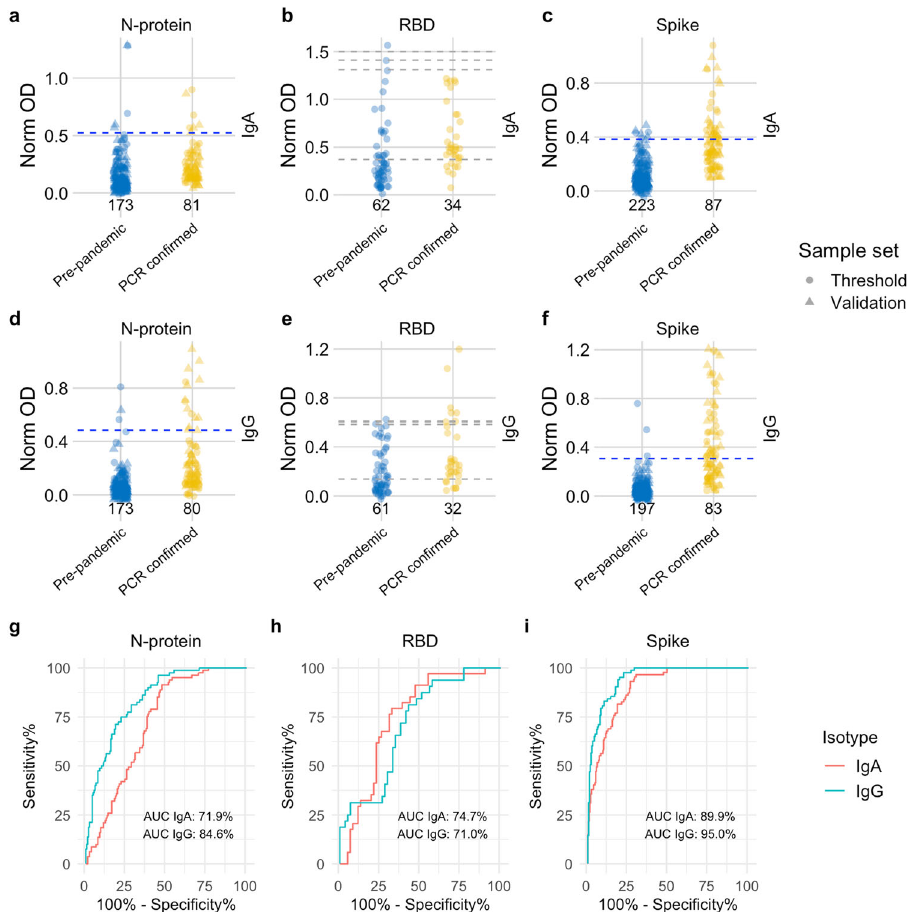
Fig. 2 Distribution of semi-quantitative titres for each assay and corresponding ROC curves. a – c Dotplots show the scatter of values for SARS-CoV-2 speci fi c IgA responses against N-protein ( N = 254), RBD ( N = 96) and spike ( N = 310), speci fi c IgG responses against N-protein ( N = 253), RBD ( N = 93) and spike ( N = 280) are shown in ( d – f ). Data are presented for known negative and known positive samples, the number of samples tested in each group is also shown under the corresponding data points. For N-protein and spike, proposed thresholds (97th – 99th percentile and Youden ’ s index) are shown as dashed lines, with the fi nal selected threshold in blue; thresholds were derived in the threshold setting phase (threshold samples shown as circles, validation samples shown as triangles). RBD was not taken forward to full evaluation, so performance in the threshold set and corresponding proposed thresholds are shown as dashed grey lines. g , i ROC curves for N-protein and spike represent assay performance determined on all threshold and validation set samples combined. h The ROC curve for RBD represents assay performance in threshold sample set. ROC = receiver operating characteristic curve. AUC = area under the curve. Norm OD = Normalised OD (a relative ratio to the serum standard). N-protein = Nucleocapsid protein. RBD = Receptor binding